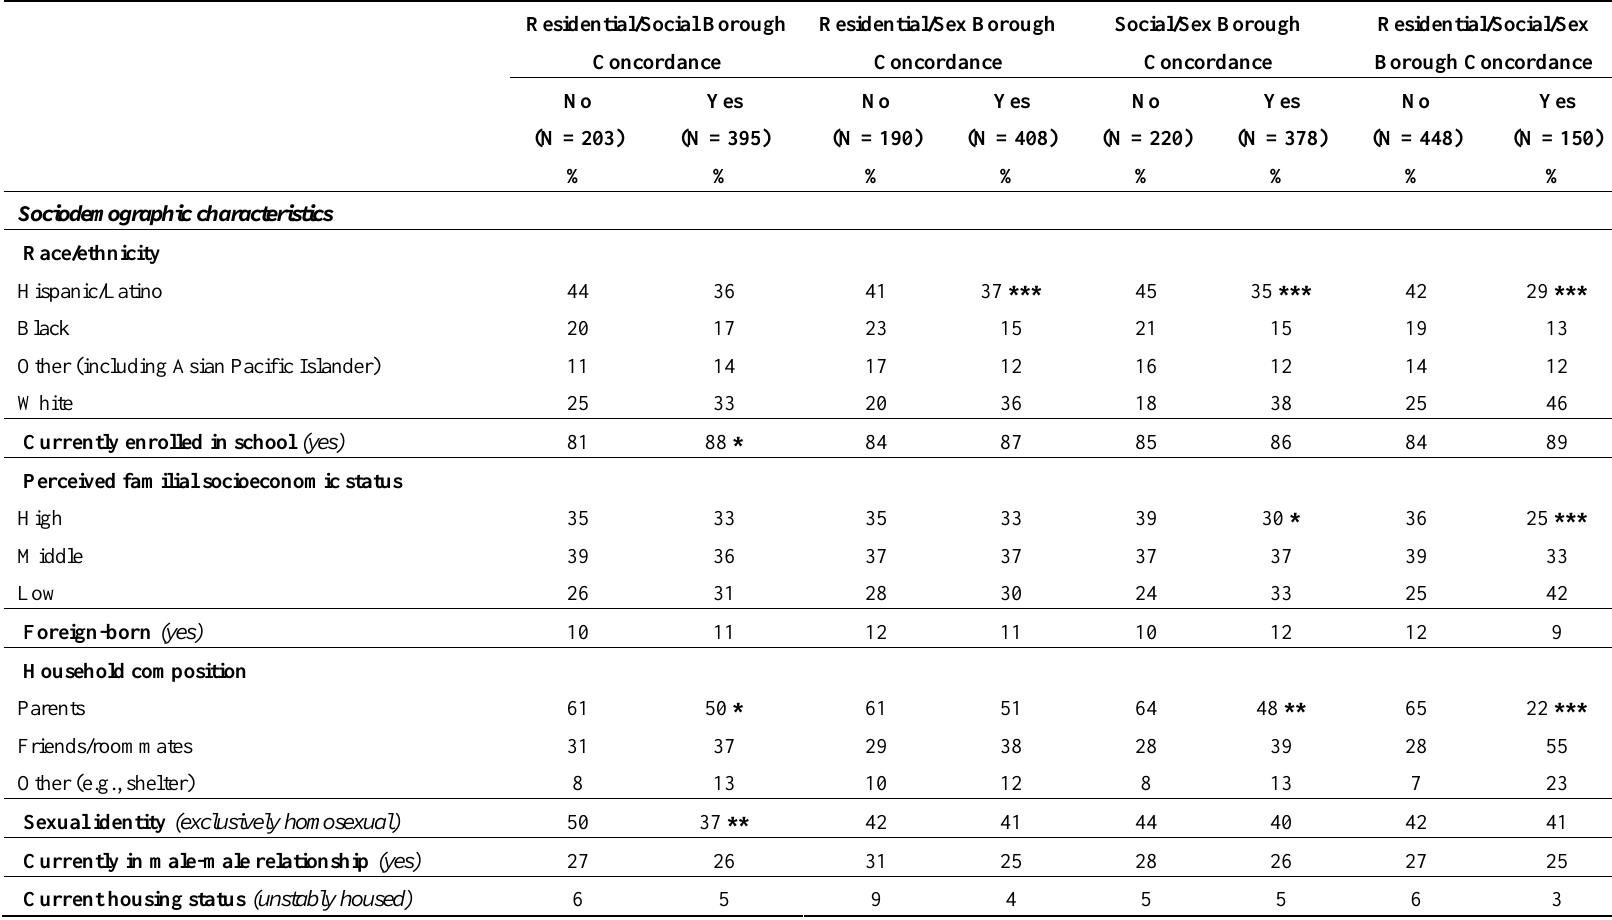
Table 2. Bivariable associations between sociodemographic characteristics, psychosocial factors, social support network characteristics substance use and sexual behaviors and borough concordance for the Project 18